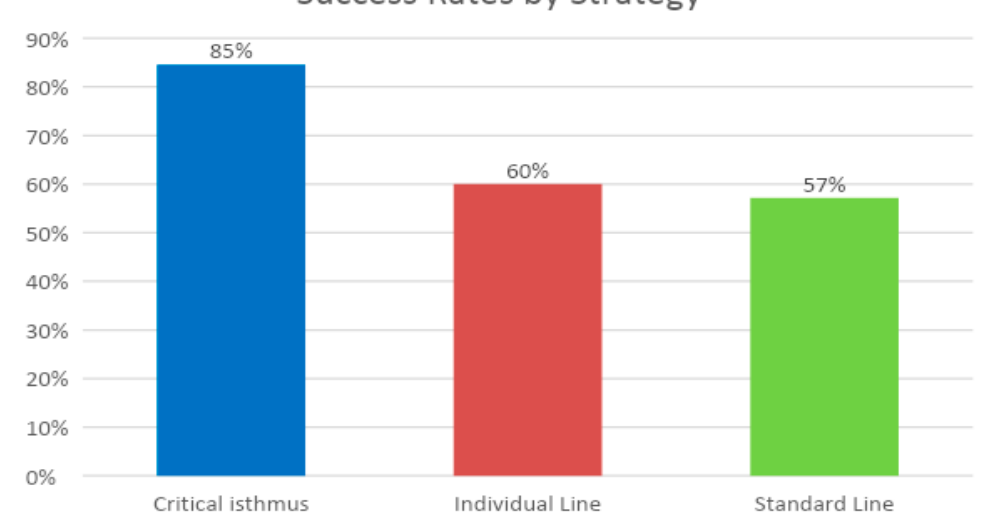
Figure 4. Clinical success dependent on the ablation strategy. Multi-procedure success after a mean follow-up time of 30 months. Differences were not significant. (Pearson Chi Square p = 0.28 and p = 0.12 when comparing critical isthmus vs. other lines).